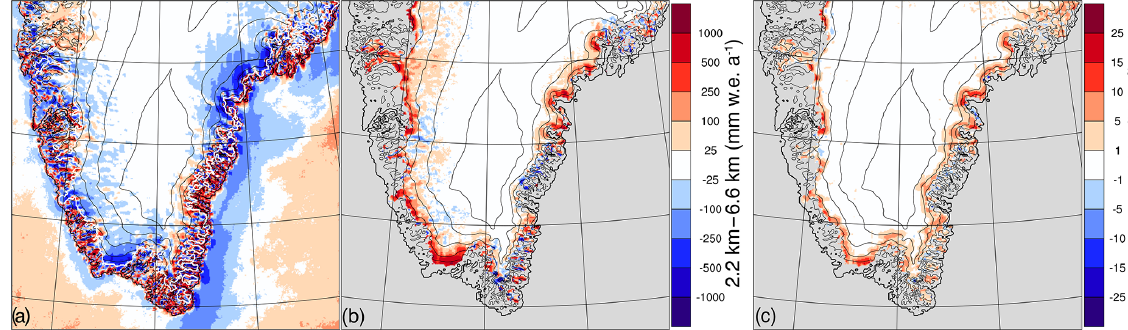
Figure 8. Differences in the mean (a) precipitation, (b) runoff, and (c) sensible heat flux between the 2.2 and 6.6km simulations. The sensible heat flux is positive if pointed towards the surface. The 6.6km results are mapped on the 2.2km grid using bilinear (a) and statistical downscaling (b, c) ,